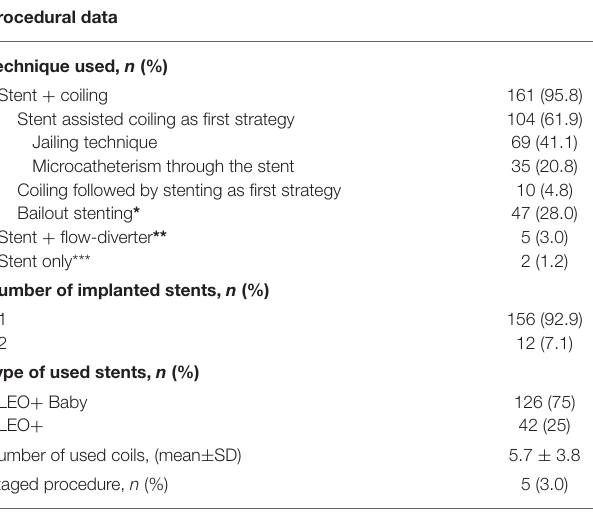
TABLE 3 | Procedural data on the evaluable analysis set in the EAS subgroup. TABLE 5 | Primary efficacy endpoint on the efficacy evaluable analysis set in the EEAS